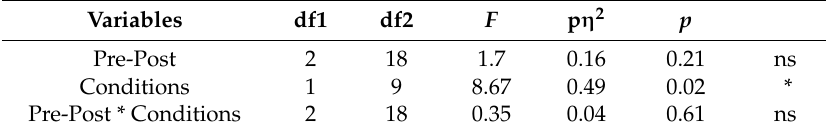
Table 9. The result of ANOVA of RSA of the trauma group.